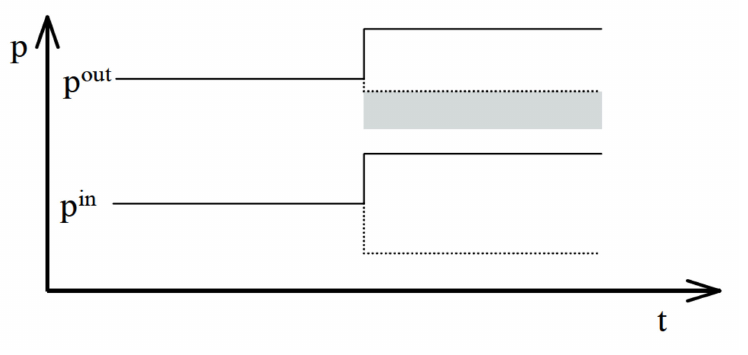
Figure 1. Magnitude